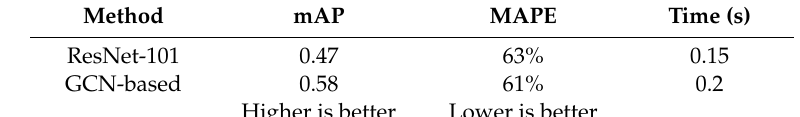
Table 3. Comparison of results for different approaches.